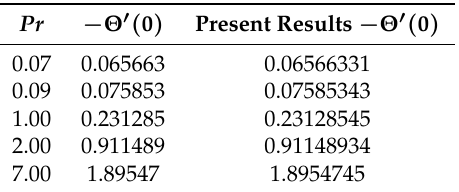
Table 1. Impact of the variation of Pr on Nusselt number for the nonzero values of the Schmidth number and the Brownian motion parameter.